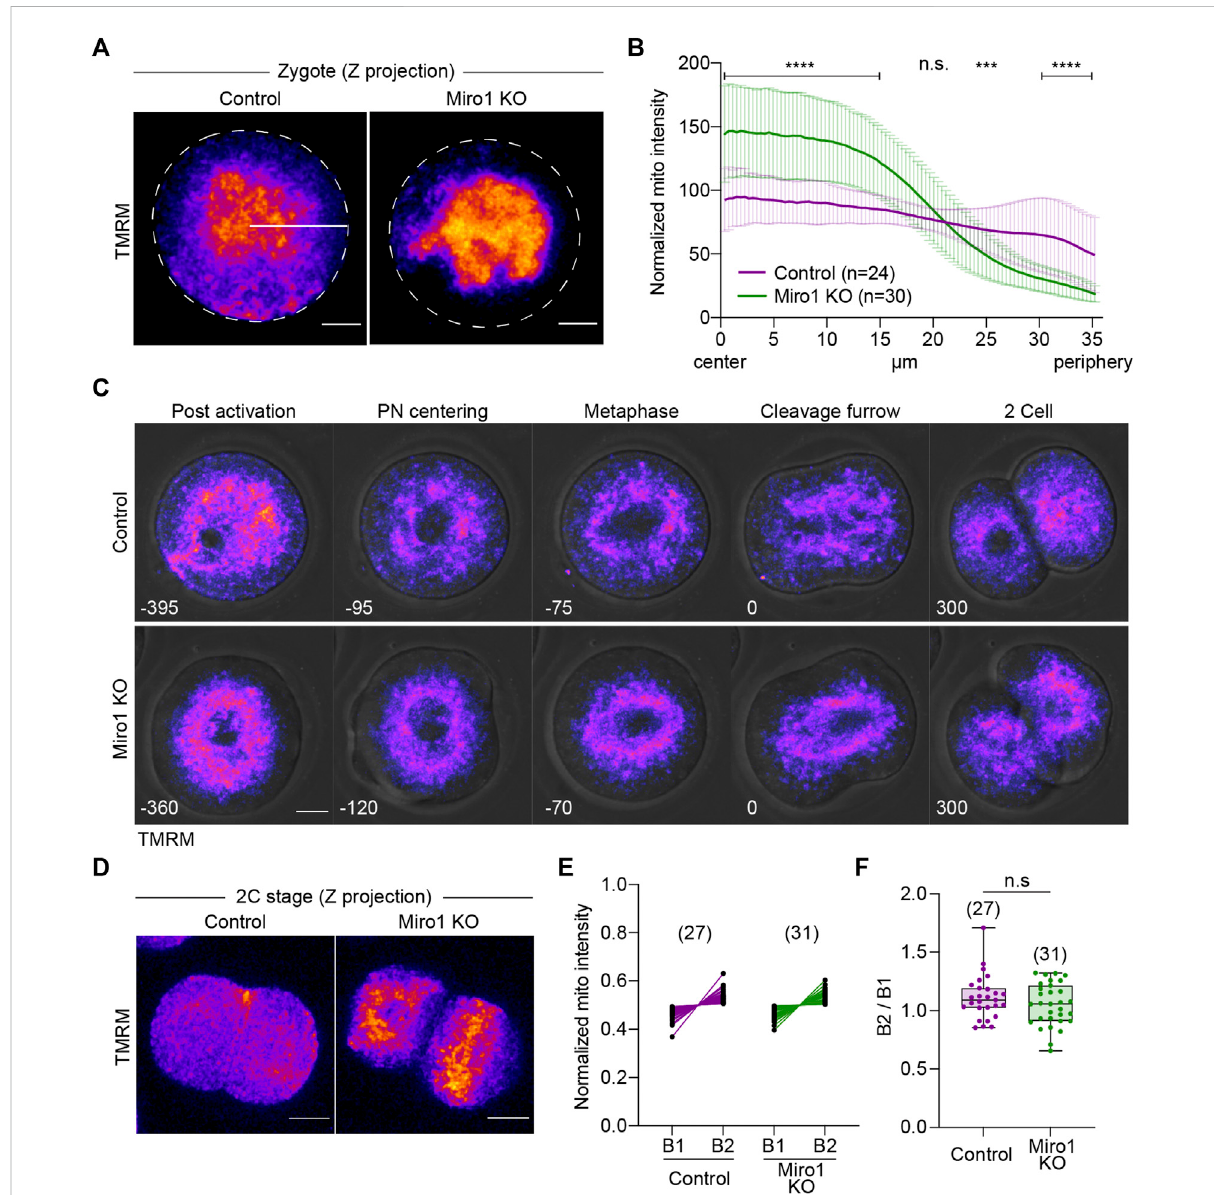
FIGURE 4 LossofMiro1resultsinseveremitochondrial disorganizationinearlyparthenotes .(A) Representative imagesof1-cellparthenotes wereimaged after the activation. Fire: TMRM. Dashed line: Oocyte membrane. White line: ROI (35 µm long) for analysis. Scale bar: 15 µm (B) Normalized mitochondrial intensity from the center to the cell periphery (35 µm) in a circle (360 ° ). Data presented as mean ± SD. Paired t -test, **** p < 0.0001, *** p < 0.001, n.s., not signi fi cant. Data are collated from 3 independent experimental replicates (C) Mitochondrial distribution during the fi rst mitotic cell division in control and Miro1 KO parthenotes. Fire: TMRM. Time: min. Scale bar: 15 µm. (D) Representative images of mitochondrial distribution in 2-cell parthenotes. Fire: TMRM. Scale bar: 15 µm. (E) Quanti fi cation data of mitochondrial inheritance in each blastomere at 2-cells. Normalized mitochondrial intensity was measured in z-projection images. (F) Ratio of mitochondrial intensity in B1 and B2. Unpaired t -test, n.s., not signi fi cant. Data are collated from 3 independent experimental